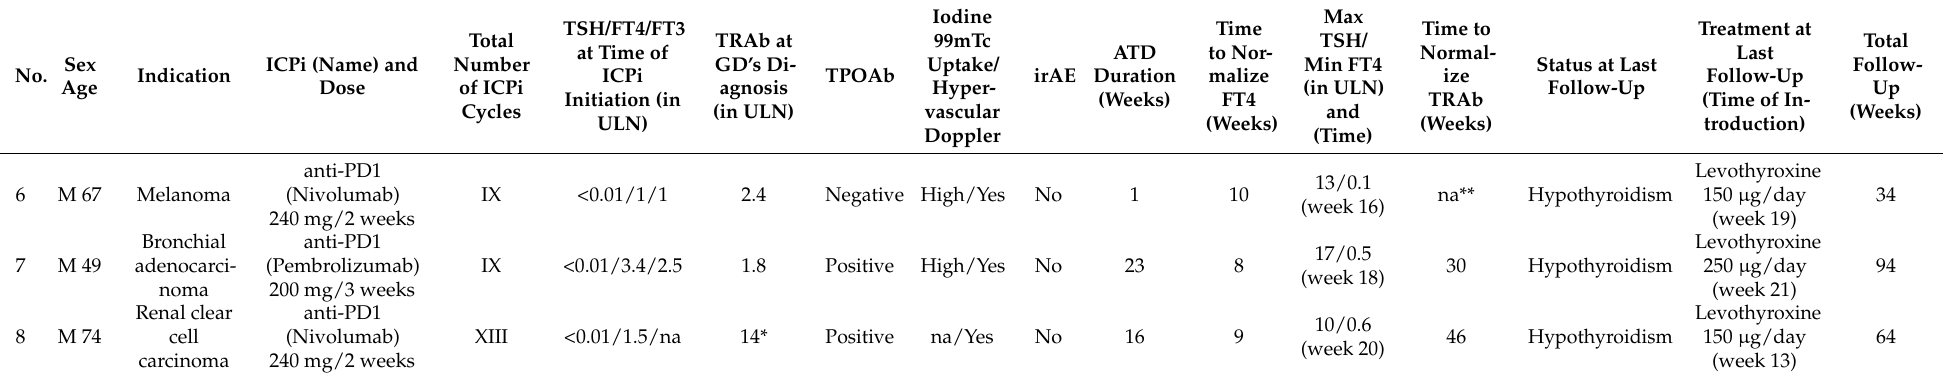
Table 2. ICPis pre-therapeutic Graves’